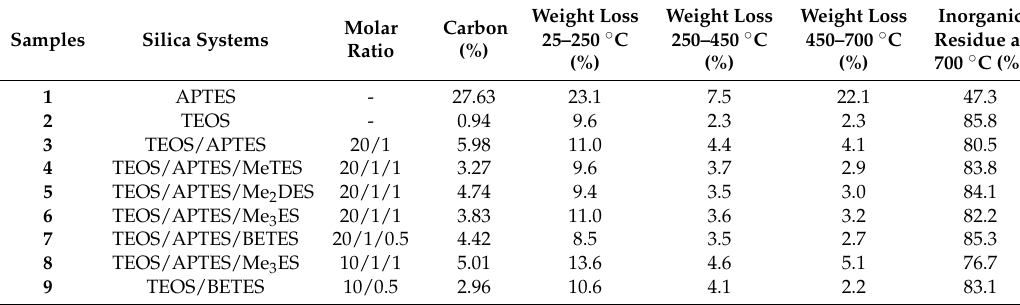
Table 1. Composition of the different silica systems and the corresponding carbon content and weight loss.